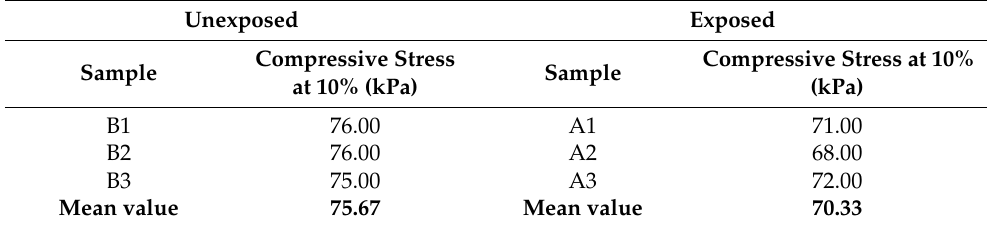
Table 3. Compressive stress at 10% strain for exposed and unexposed samples.